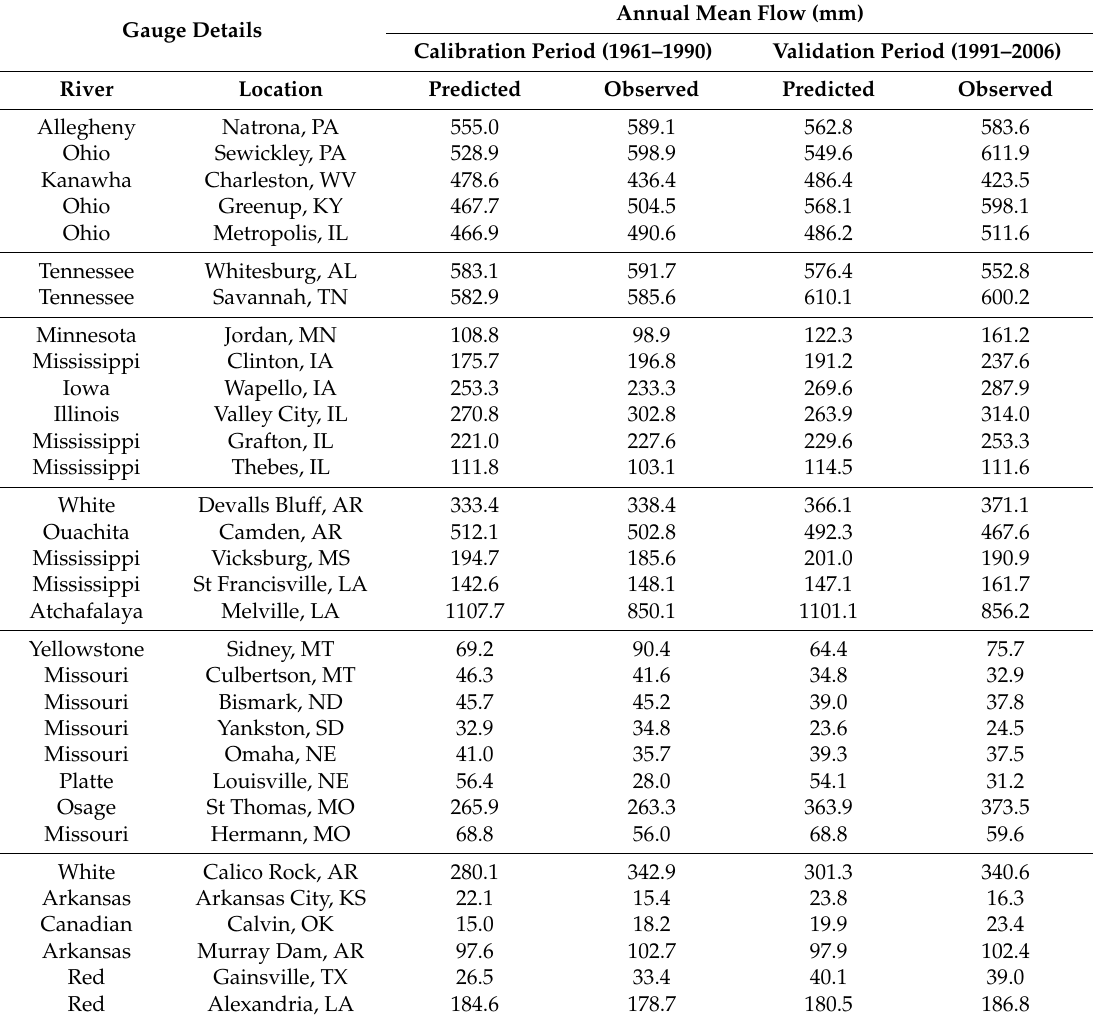
Table 4. Comparison of predicted and observed annual average flow